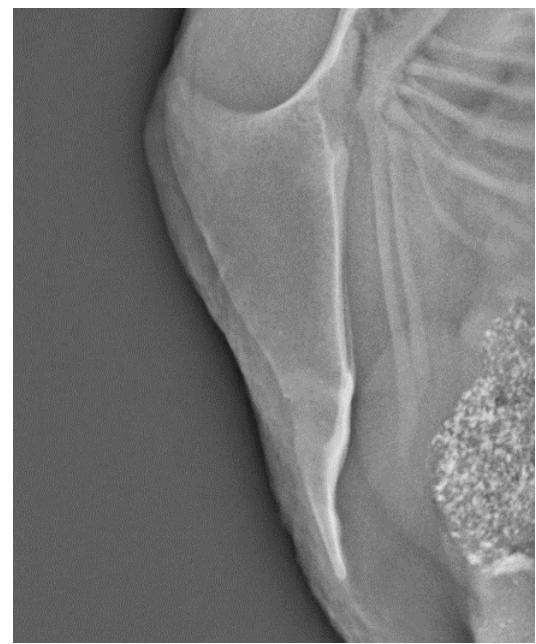
Figure 3. A keel bone with multiple fractures, age 63 weeks of age.